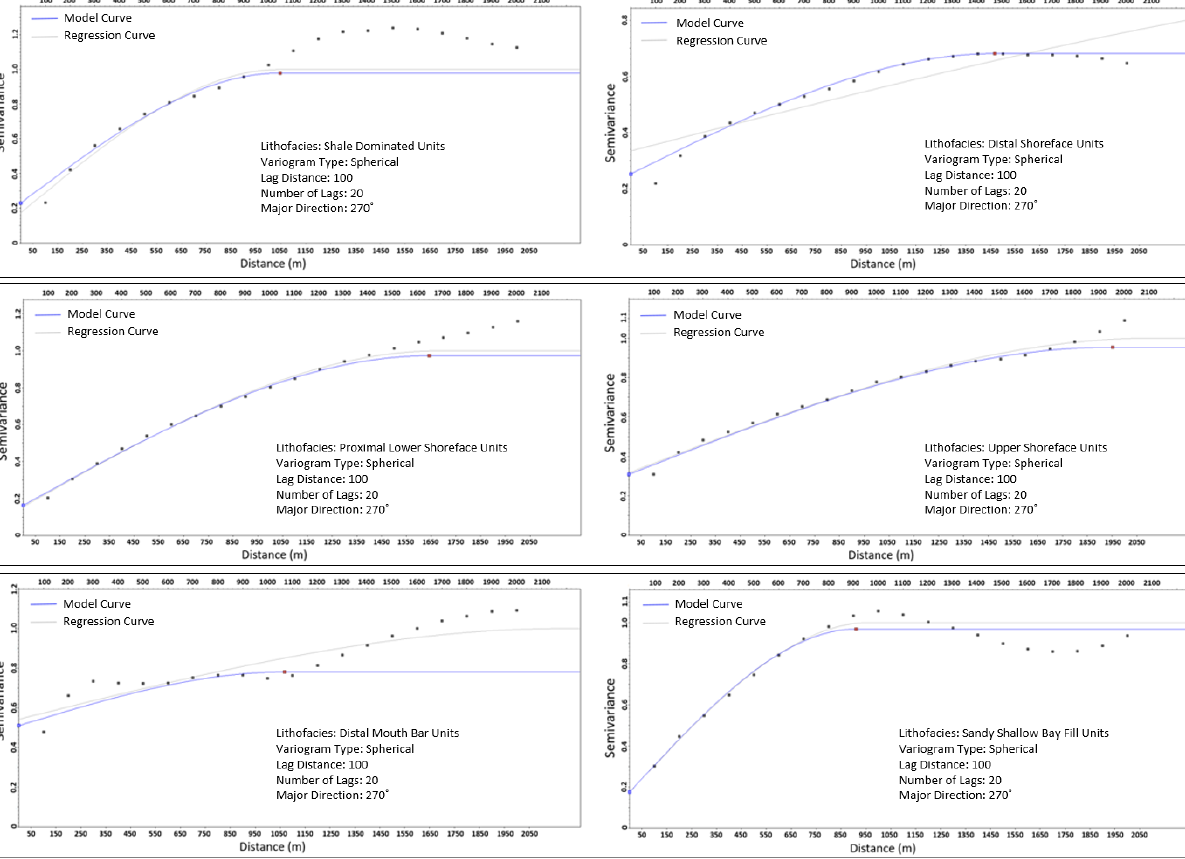
Figure 10. Variogram model of dominant lithofacies units from the forward stratigraphic model. The “dots” indicate the number of lags in the variogram through the major direction (NE–SW) of the stratigraphic